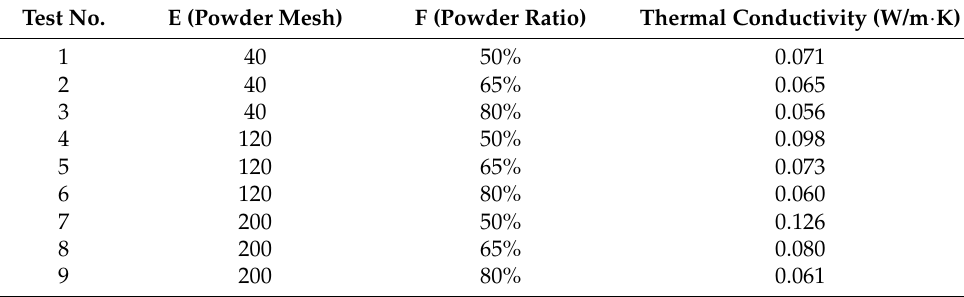
Table 8. Results thermal conductivity